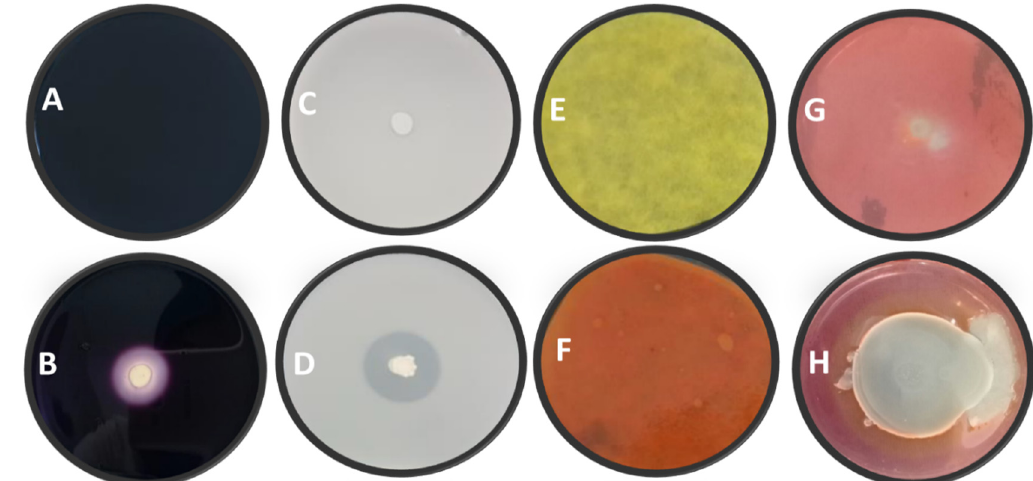
Figure 1. Capacity of bacterial antagonists to produce lytic enzymes and HCN. Amylase activity assay ( A , B : negative and positive responses, respectively). Protease production assay ( C , D : negative and positive responses, respectively). HCN production assay ( E , F : negative and positive responses, respectively). Cellulase activity assay ( G , H : moderate and positive responses, respectively).